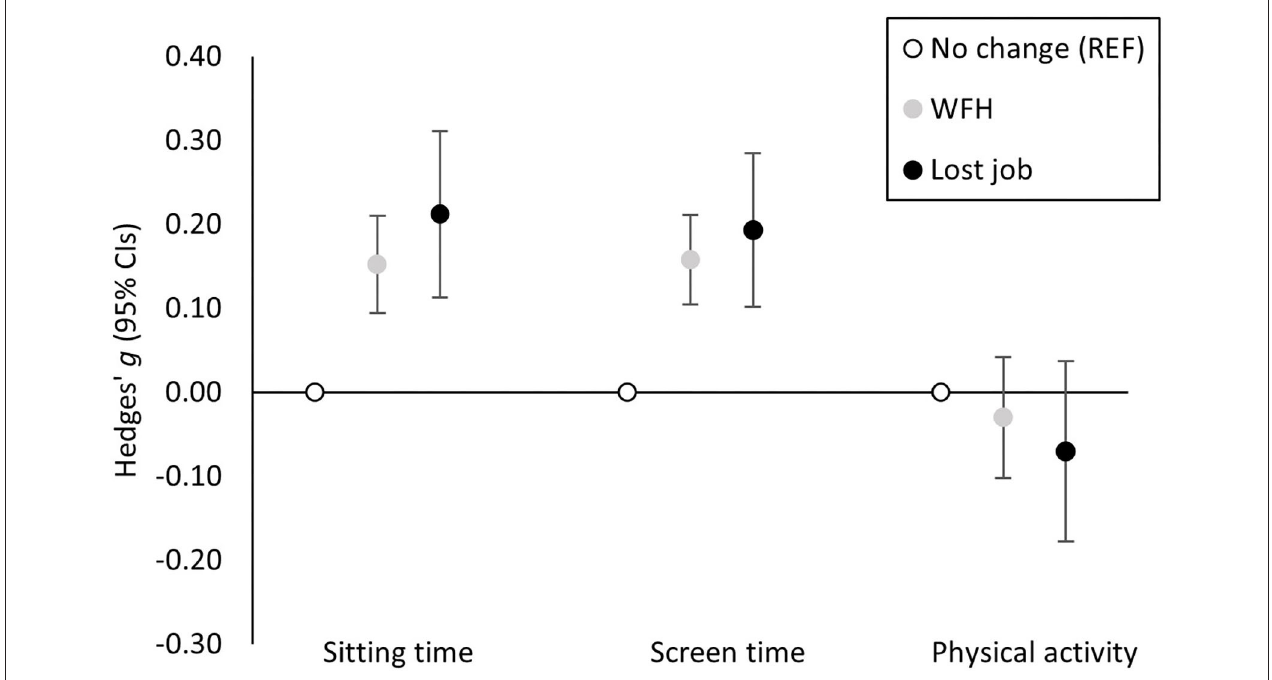
FIGURE 1 | Hedges’ g effect sizes and associated 95% confidence intervals (CIs) demonstrating the magnitude of the adjusted association between working from home (WFH) and job loss (compared to unchanged employment) and sitting time, screen time, and physical activity such that more time in a behavior is illustrated by a positive effect size. REF, reference